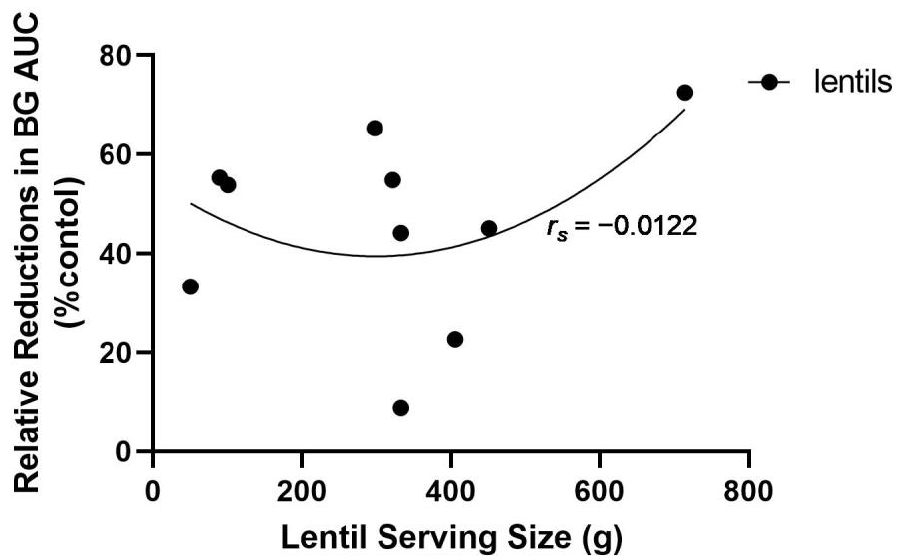
Figure 2. Relative reductions (%) in area under the blood glucose response curve (BG AUC) according to lentil serving sizes (g) with reference to controls. Relative reduction was calculated using the formula: ((Lentil BG AUC–Control BG AUC)/Control BG AUC) × 100. A quadratic curve best fit this data ( r s = − 0.0122; n = 10; ns ).